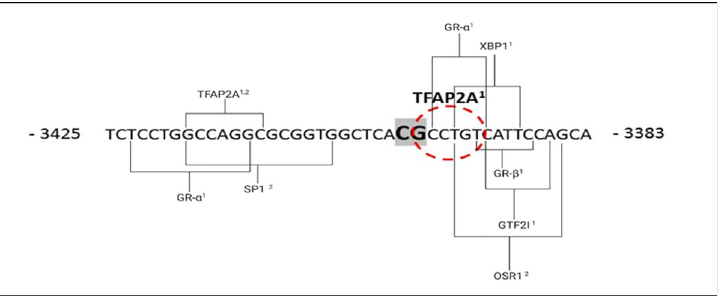
Fig 6. Schematic illustration of transcription factors binding to differentially methylated CpG -3400 and to adjacent regions. In silico transcription factor prediction analysis identified transcription factor AP2-alpha (TFAP2A) binding site directly over CpG –3400 upstream of the ADIPOQ gene transcription start site, using ALGGEN-PROMO 1 and ALIBABA 2.1 2 software. Eight other transcription factor binding sites were identified within the region -3425 to -3383 adjacent to the region of altered DNA methylation. The following factors were identified: GR α —Glucocorticoid Receptor Alpha; XBP1— X-Box Binding Protein 1; SP-1— Specificity Protein 1 Transcription Factor; OSR1— Odd- Skipped Related Transcription Factor 1; GR β —Glucocorticoid Receptor Beta ; GTF2I –General Transcription Factor IIi and TFAP2A - Transcription Factor AP2-alpha; Bold-face/highlighted nucleotides—indicate differentially methylated CpG -3400; Brackets—transcription factor binding regions adjacent to CpG -3400; Red dotted circle–TFAP2A binding